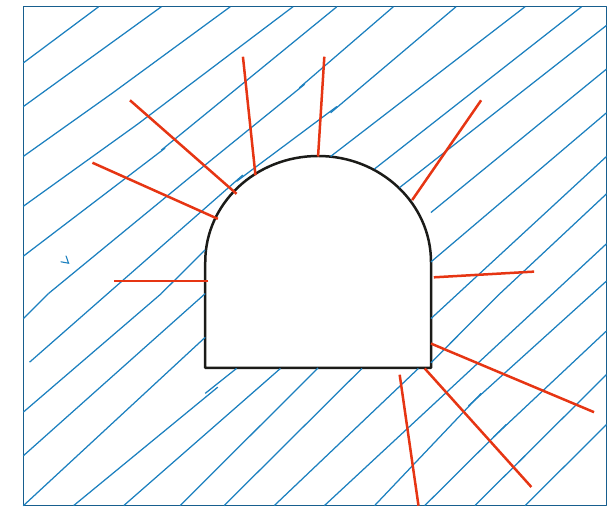
Figure 10: Asymmetric supporting technology.